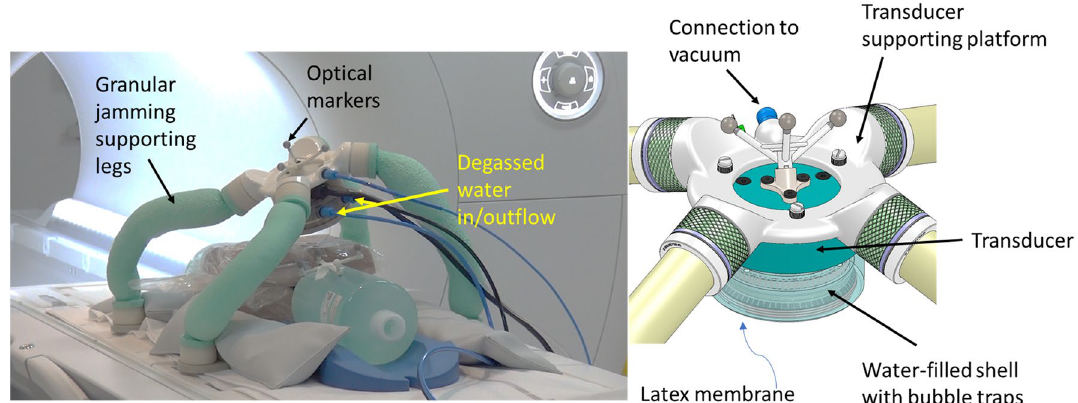
Figure 2. Photograph and schematic view of the holding system. The ultrasound transducer is encapsulated in a water-filled shell and fixed to a transducer-specific supporting platform. This platform is hermetically connected to the granular jamming supporting legs, which are naturally flexible and can be rigidified by applying a pneumatic